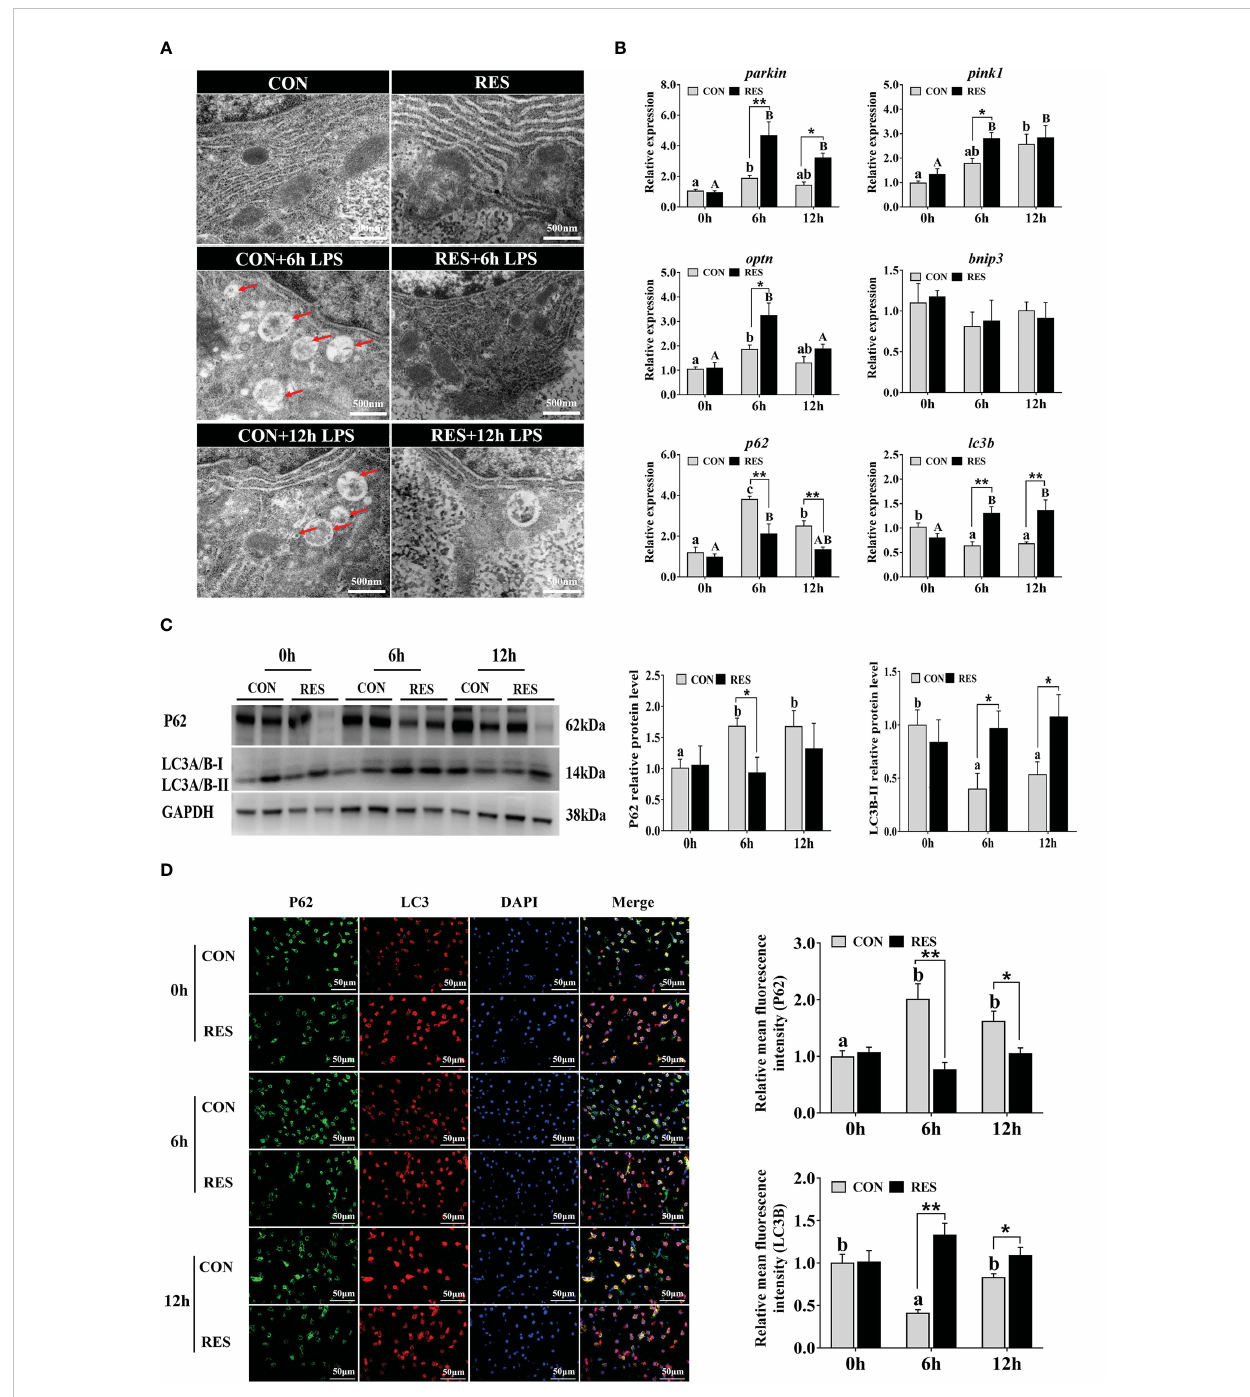
FIGURE 8 Effect of dietary RES on mitochondrial autophagy in the liver of gibel carp at 6 h and 12 h after LPS injection. (A) Ultrastructural changes of hepatocytes under TEM. Scale bar = 500 nm. Red arrows represent the autophagosome. (B) Mitophagy-related mRNA levels were determined with qRT-PCR. (C) Western blots for P62 and LC3B and quanti fi cation results. (D) Co-localization analysis of P62 (green) and LC3 (red) in the hepatocytes of gibel carp and the relative fl uorescence intensity. DAPI staining is shown in blue. Bars = 50 µm. Data are mean ± SEM (n = 6). The lowercase letters represent signi fi cant differences among diverse LPS durations in the CON group ( P < 0.05); the uppercase letters represent signi fi cant differences among diverse LPS durations in the RES group ( P < 0.05). *( P < 0.05) and **( P < 0.01) represent signi fi cant differences between the CON and RES groups. Parkin , parkin RBR E3 ubiquitin-protein ligase; pink1 , PTEN-induced kinase 1; optn , optineurin; bnip3 , BCL2 interacting protein 3; lc3b , microtubule-associated proteins 1A/1B light chain 3B; p62 ,